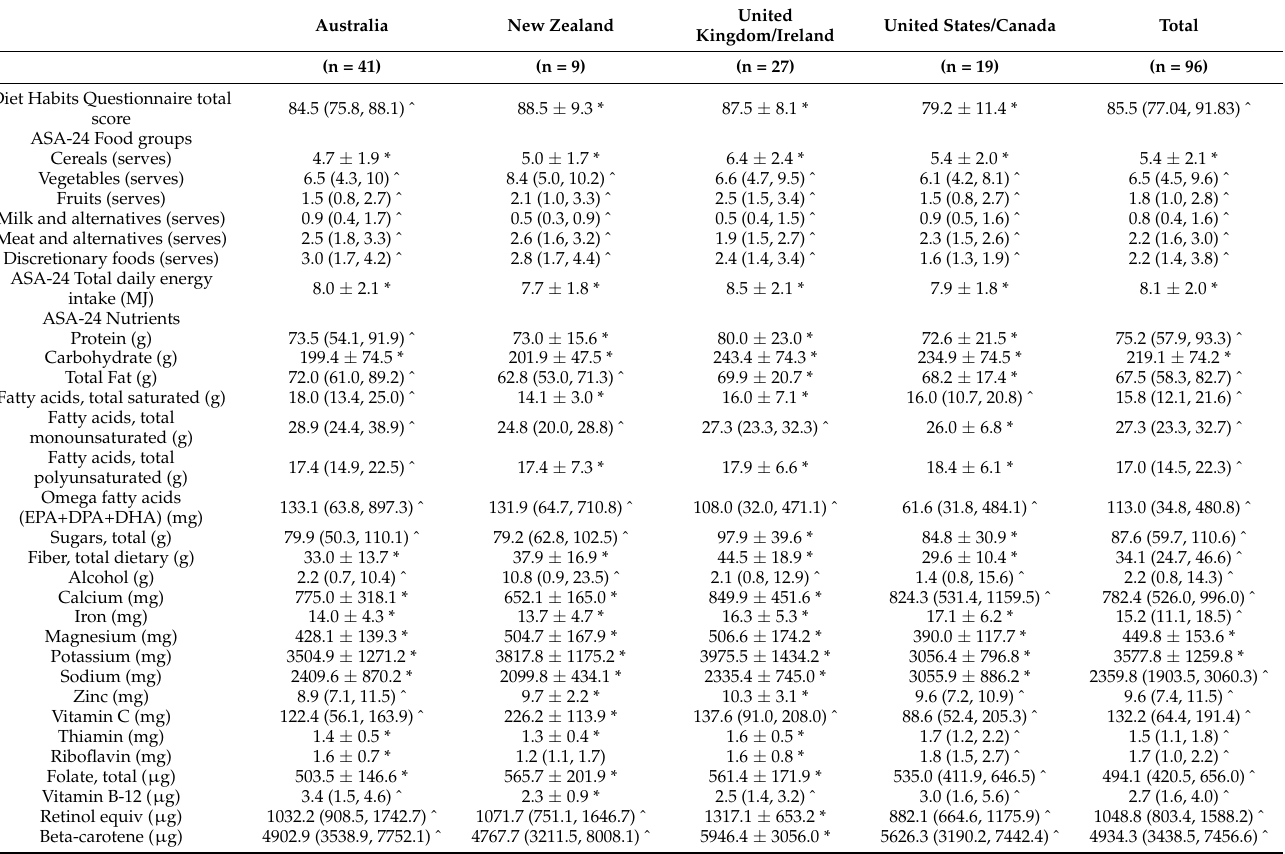
Table 2. Intakes of nutrients and food groups of the sub-sample from the Health Outcomes and Lifestyle In a Sample of people with Multiple sclerosis (HOLISM) cohort, presented for the total sample and by